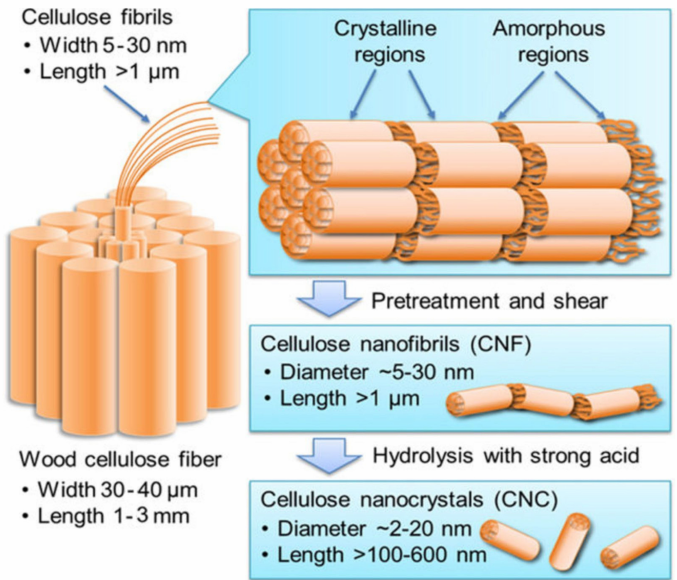
Figure 4. A schematic of production of the NFC and CNC from wood. Reprinted with permission from Ref. [49]. Copyright © 2016, American Chemical